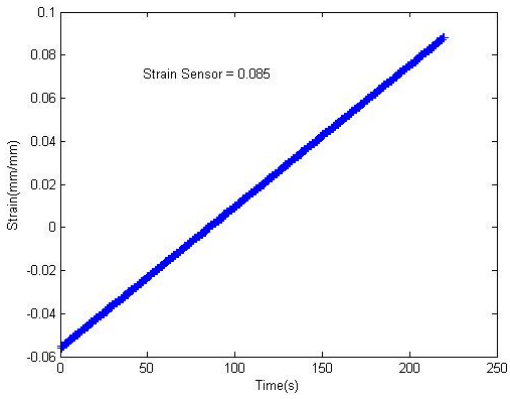
Figure 6. Strain vs. time curve.